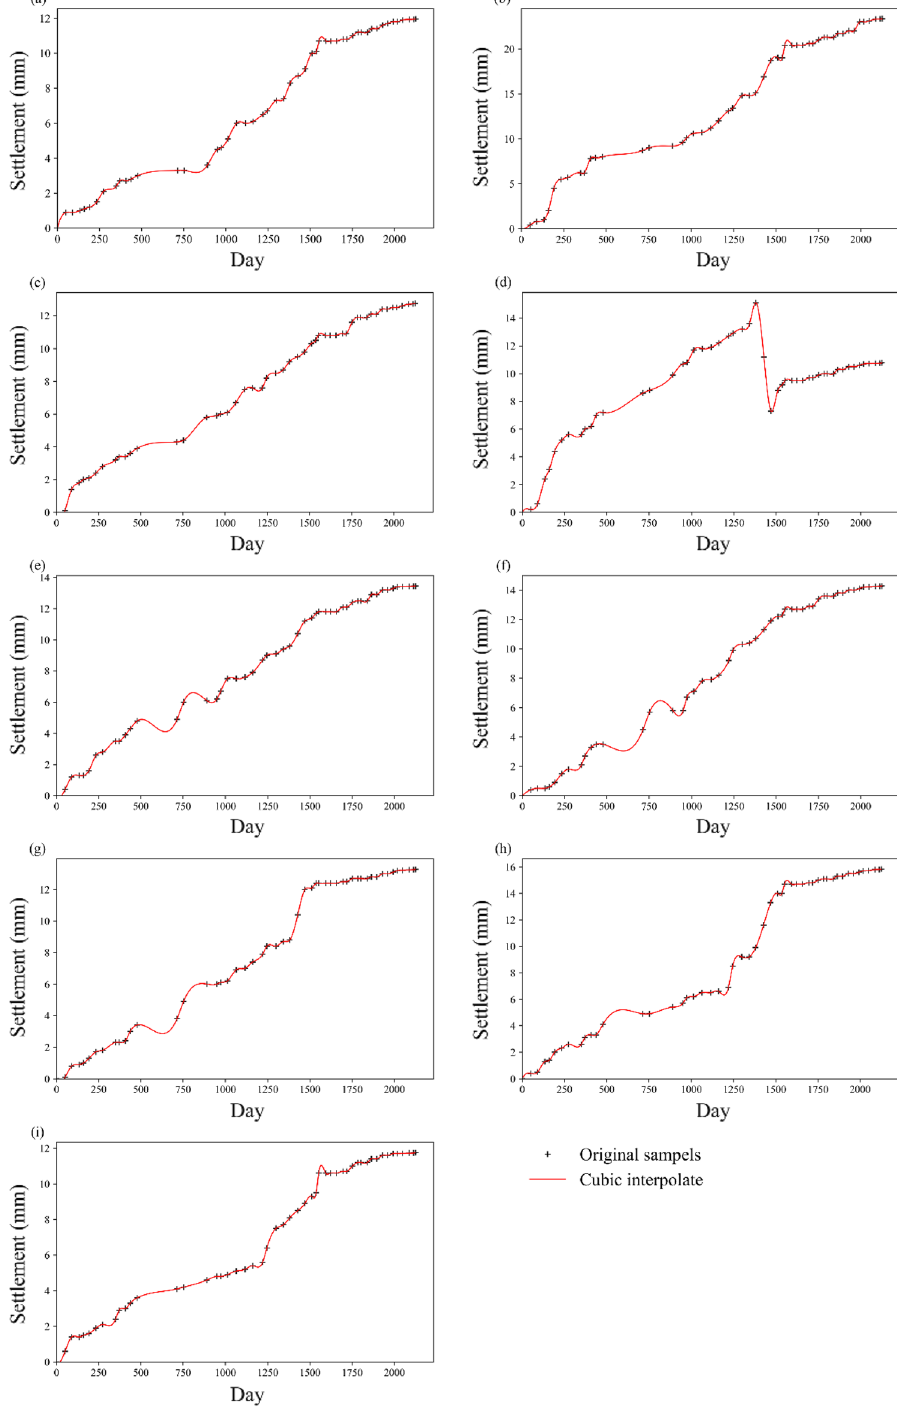
Figure 4. Cubic spline interpolation results of the settlement data: ( a ) TP1-1; ( b ) TP1-2; ( c ) TP1-3; ( d ) TP2-1; ( e ) TP2-2; ( f ) TP2-3; ( g ) TP3-1; ( h ) TP3-2; and ( i )